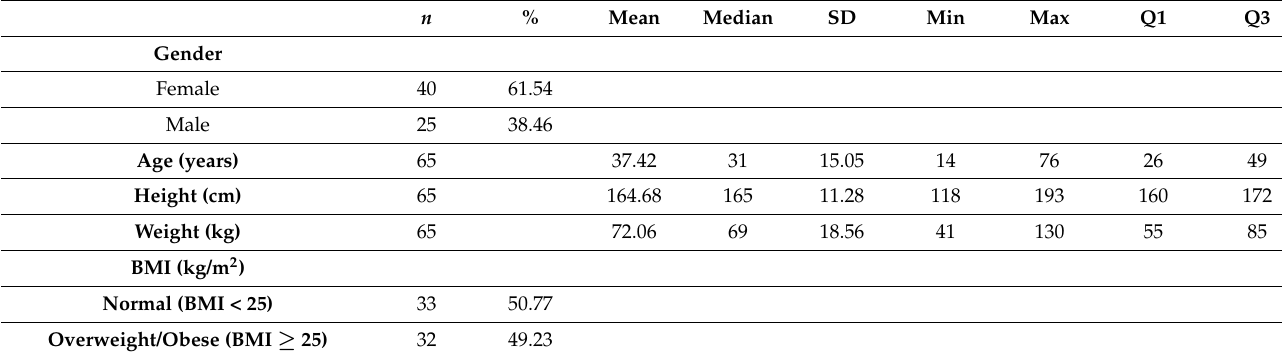
Table 1. Characteristics of participants ( n =